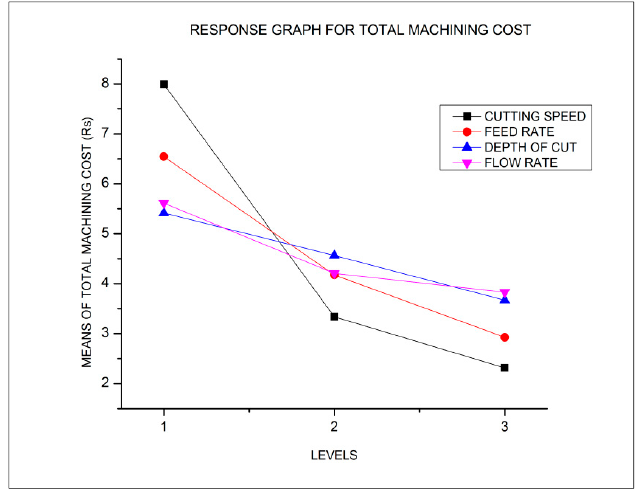
Figure 5. Analysis on total machining cost.